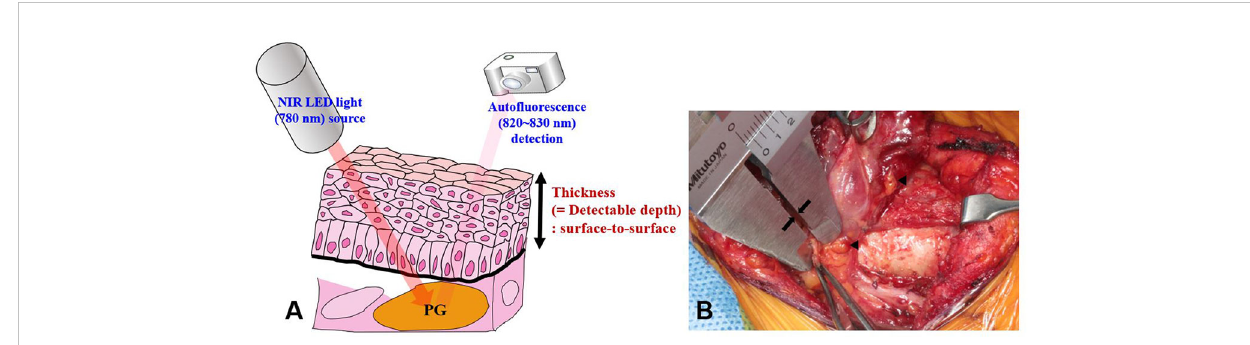
FIGURE 1 Measurement of the detectable depth of the PG. (A) When the PG is illuminated with 780 nm NIR light, it emits auto fl uorescence of wavelength 820 – 830 nm. The camera detects the emitted light. (B) Detectable depth was measured by a highly experienced surgeon (K.D. Lee) using a Vernier caliper (see arrows). Arrowheads indicate PGs. NIRAF, near-infrared auto fl uorescence; PGs, parathyroid